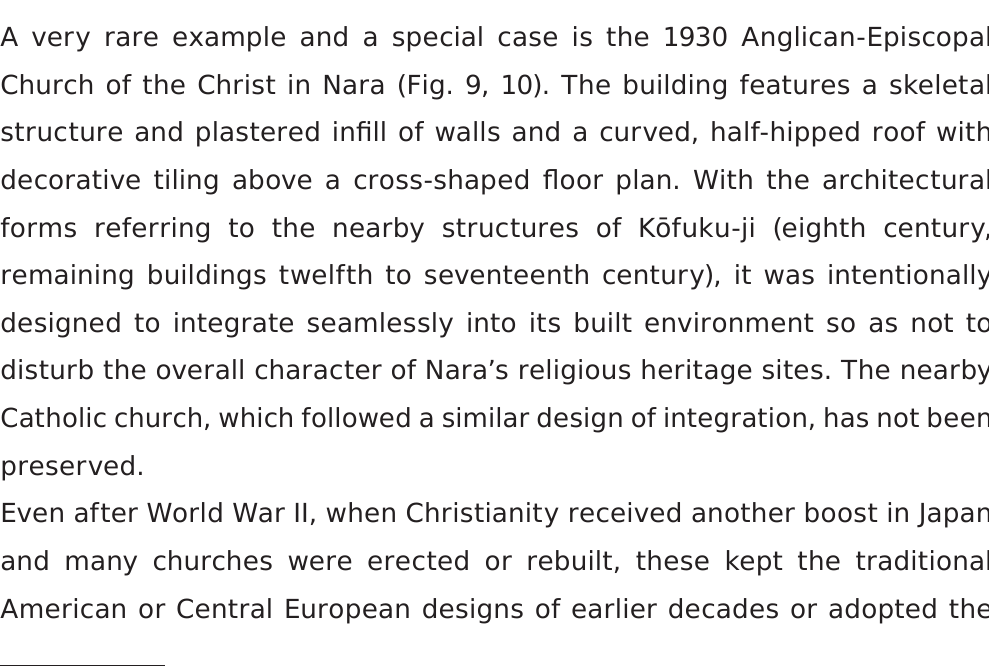
FIgure 9+10 ANGLICAN-EPISCOPAL CHURCH OF THE CHRIST IN NARA (1930, KICHITARO OKI) (FIG 9. COURTESY OF MR. MARTIN FEILER,